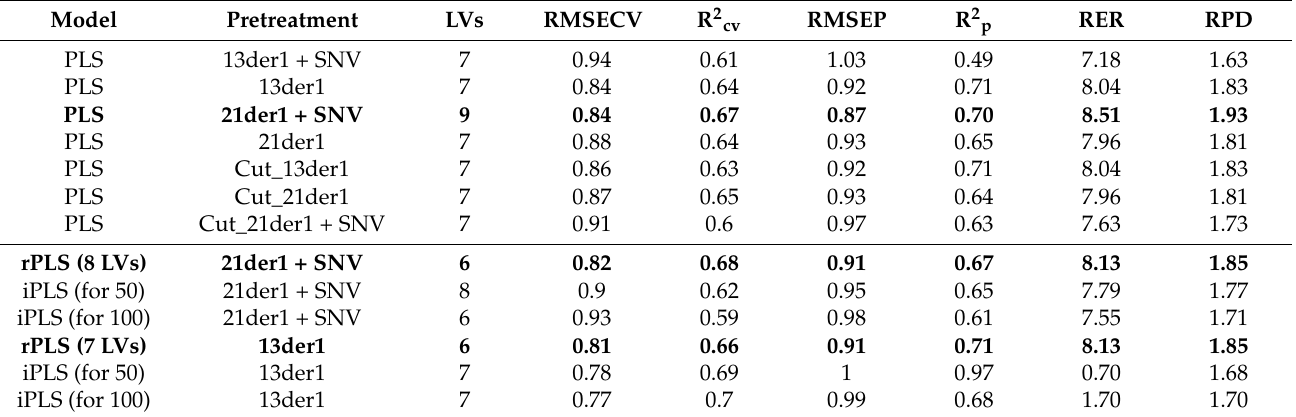
Table 3. Summary of partial least squares regression (PLS) results and summary of PLS results apply- ing variables selection techniques to WDB-2020 for SSC ( ◦ Brix) prediction models. The best PLS mod- els are marked in bold (xder1 = first derivative with x number of smoothing points; SNV = standard normal variate; LVs = latent variables; RMSECV = root mean square error of cross validation; RMSEP = root mean square error of prediction; RER = range error ratio; RPD = ratio of performance to